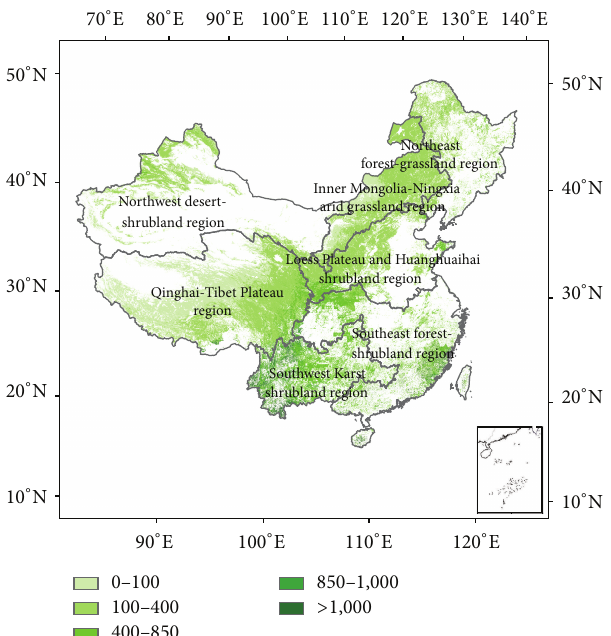
Figure 2: The spatial distribution of grassland productivity over china in the year of 2010.